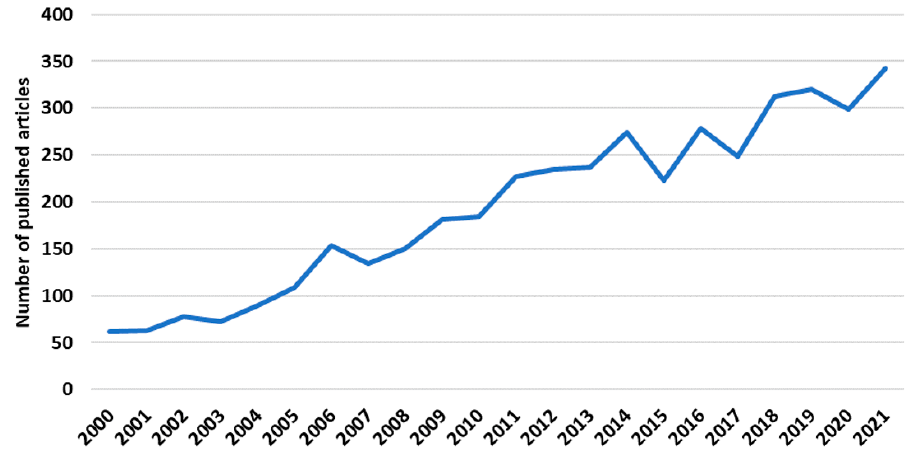
Figure 3. The annual number of articles published related to Mediterranean fires. Data retrieved from Web of Science [32] for dates between 2000 and 2021.